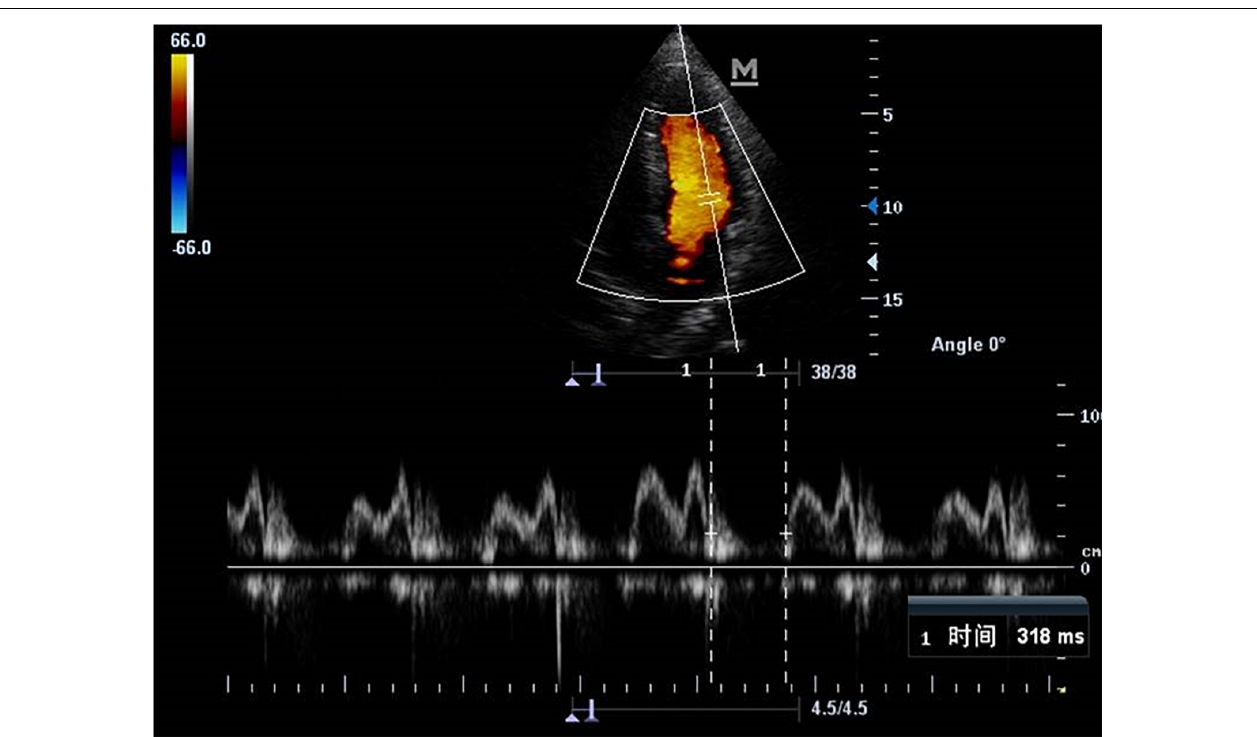
FIGURE 4 | The blood flow spectrum of mitral valve in patient with clinical brain